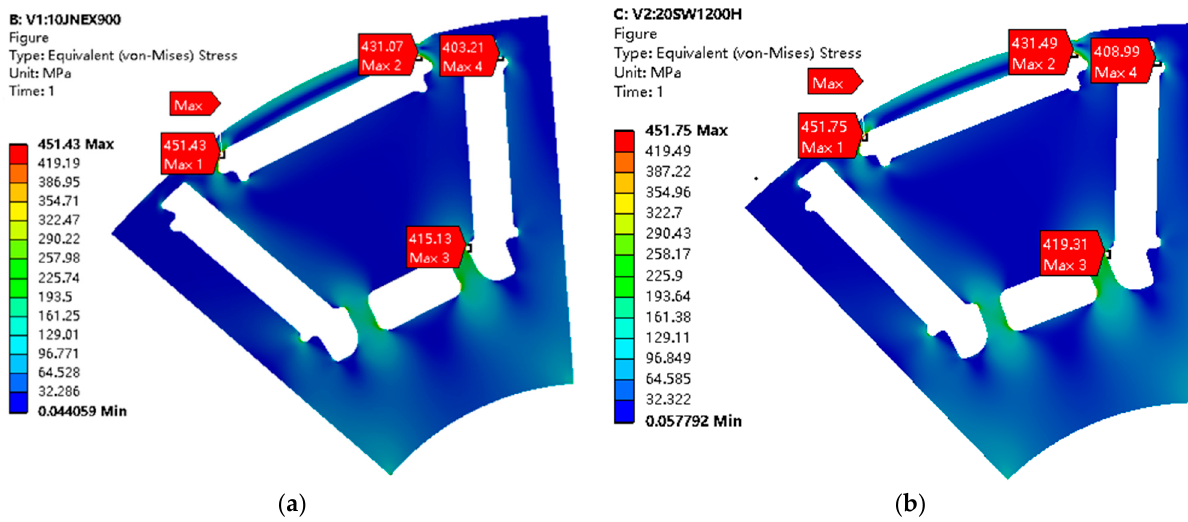
Figure 14. Mechanical stress distribution of rotor cores of two materials at 19,000 r/min. ( a ) Figure 14. 10JNEX900. ( b ) 20SW1200H. ( a ) 10JNEX900. ( b )